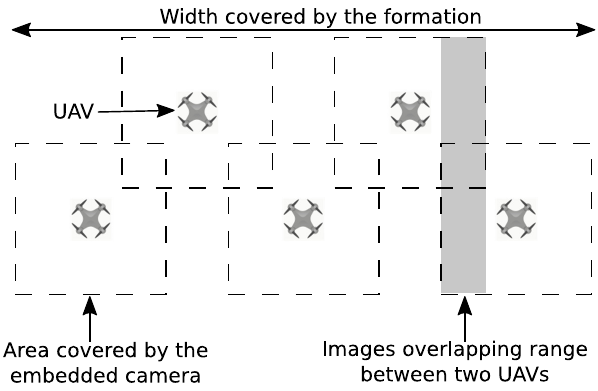
Figure 3. Flight formation for spiral scanning.